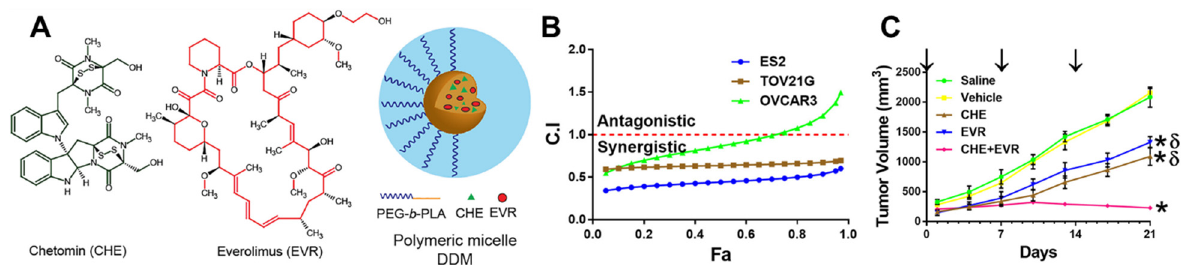
Figure 5. ( A ) Dual drug loaded polymer micelle loaded with chetomin (CHE) and everolimus (EVR) in the core. ( B ) The dual drug loaded micelles is synergistic compared to the single drug loaded micelles for TOV21G and ES2 cells in vitro ( CI < 1). ( C ) The dual drug loaded micelles are more effective at reducing tumor volume compared to the single drug loaded micelles in an ES2 xenograft model. * Represents significant difference from control (saline), δ represents significant difference from dual drug loaded micelles evaluated using one way ANOVA with Tukey's Multiple Comparison Test (compare all pairs of columns) using a significant level ( α ) of 0.05, n = 4. Adapted from [98]. Copyright 2019, with permission from Elsevier.